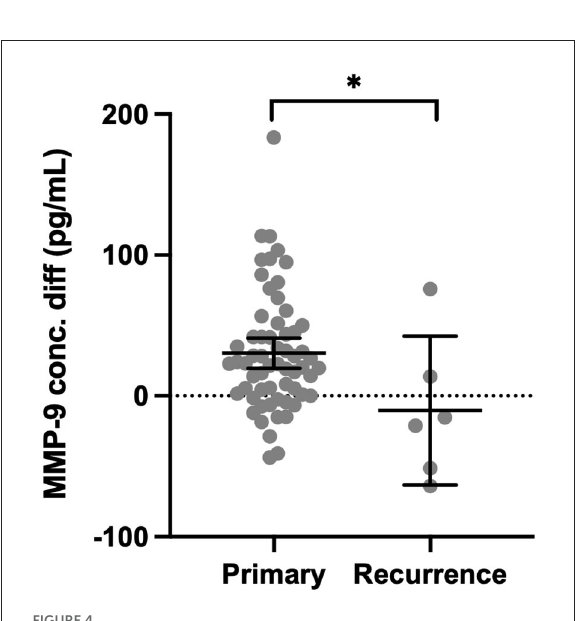
FIGURE4 Concentration difference (conc. diff) for MMP-9 in primary CSDH ( n = 61) and recurrent CSDH ( n = 6) fluid, as determined by plasma concentration minus CSDH fluid concentration. Line (median), bars (IQR), and statistically significant differences are shown as * p <